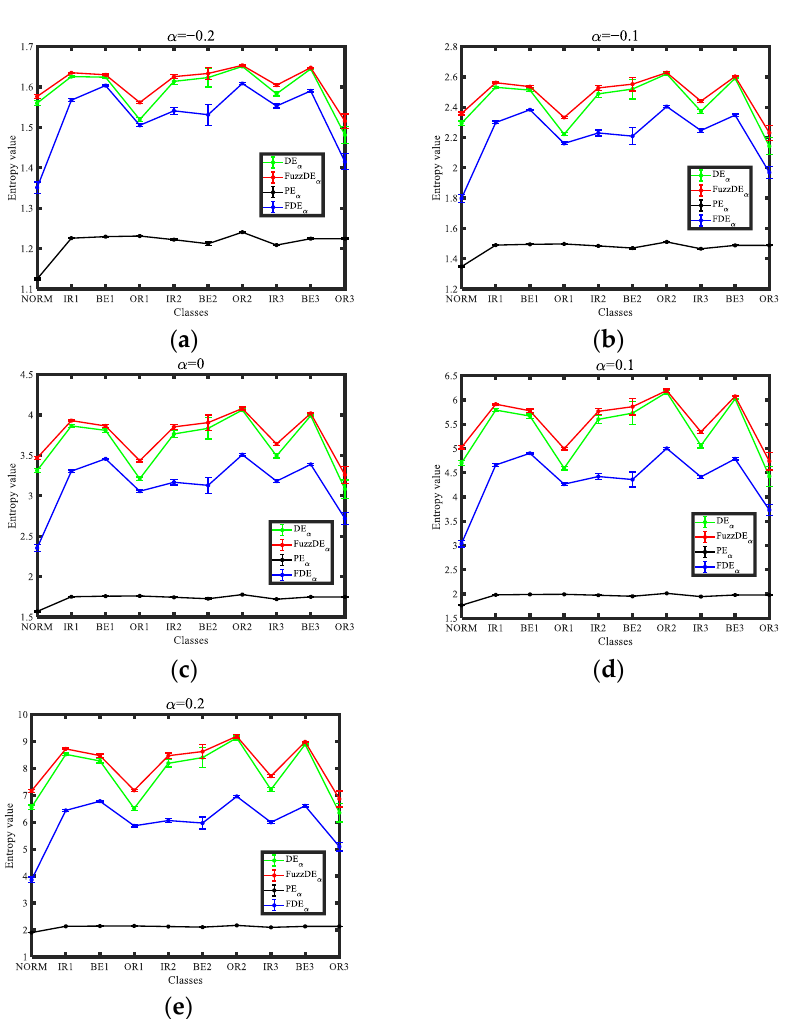
Figure 10. Distribution of fractional entropy features of different classes of bearing signals. ( a ) 𝛼 = −0.2 ; ( b ) 𝛼 = −0. 1; ( c ) 𝛼 = 0; ( d ) 𝛼 = 0.1; ( e ) 𝛼 = 0.2